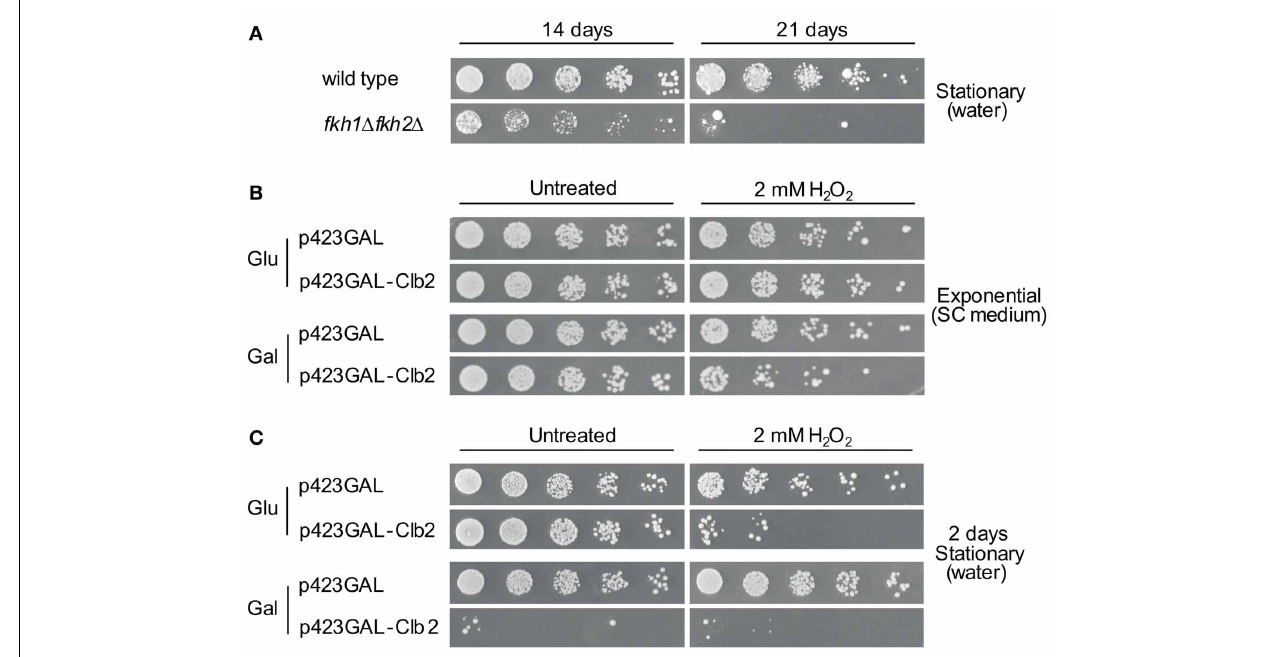
FIGURE 7 | High Clb2 levels influence survival of yeast cells under oxidative stress conditions. (A) Survival of wild type and fkh1 (cid:2) fkh2 (cid:2) cells upon nutrient limitation. Yeast strains were grown to saturation (OD 600 ∼ 1 . 6) and further incubated in H 2 O. Samples of cultures were spotted in 1:5 serial dilutions on SC medium after 14 or 21 days. (B,C) Clb2 overexpression in exponentially grown (B) and stationary (C) cells